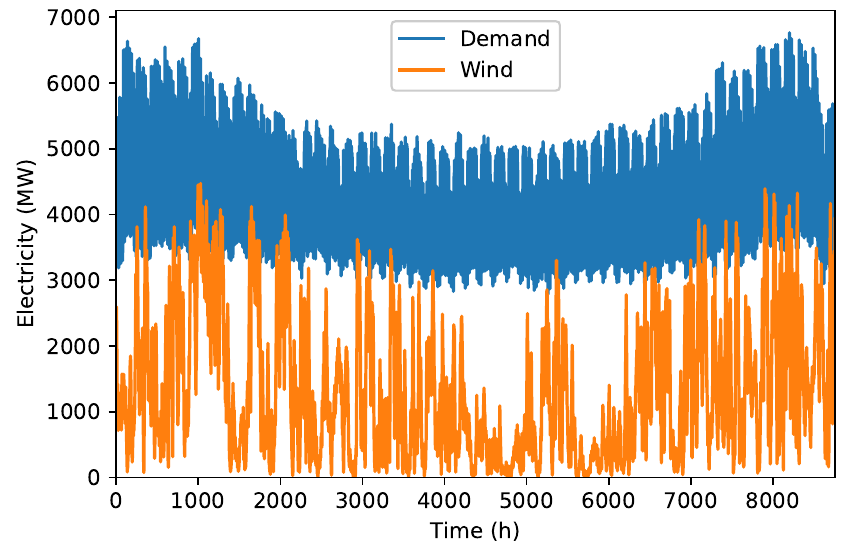
Figure 5. 2021 Ireland’s all-island demand and wind generation